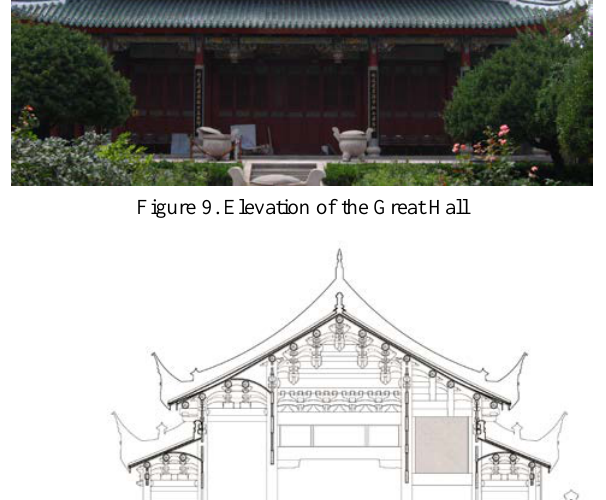
Figure 10. Section of the Great Hall